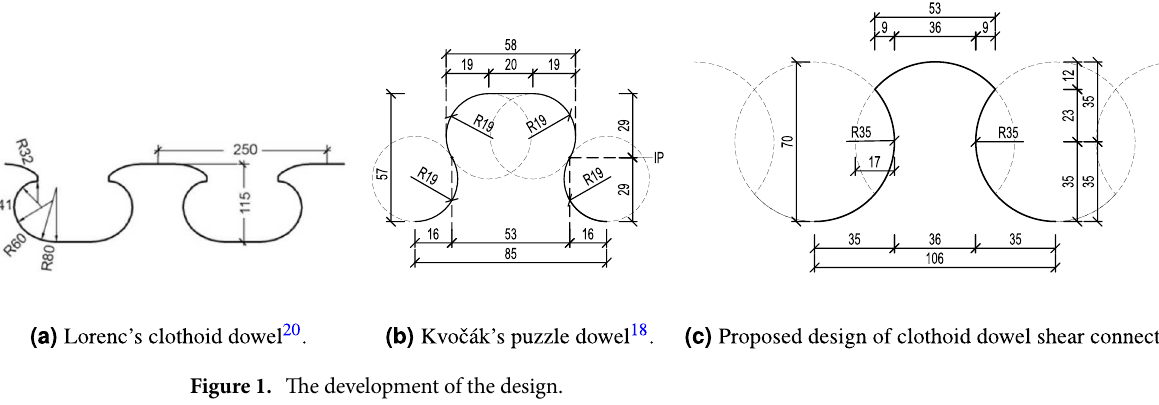
Figure 1. The development of the